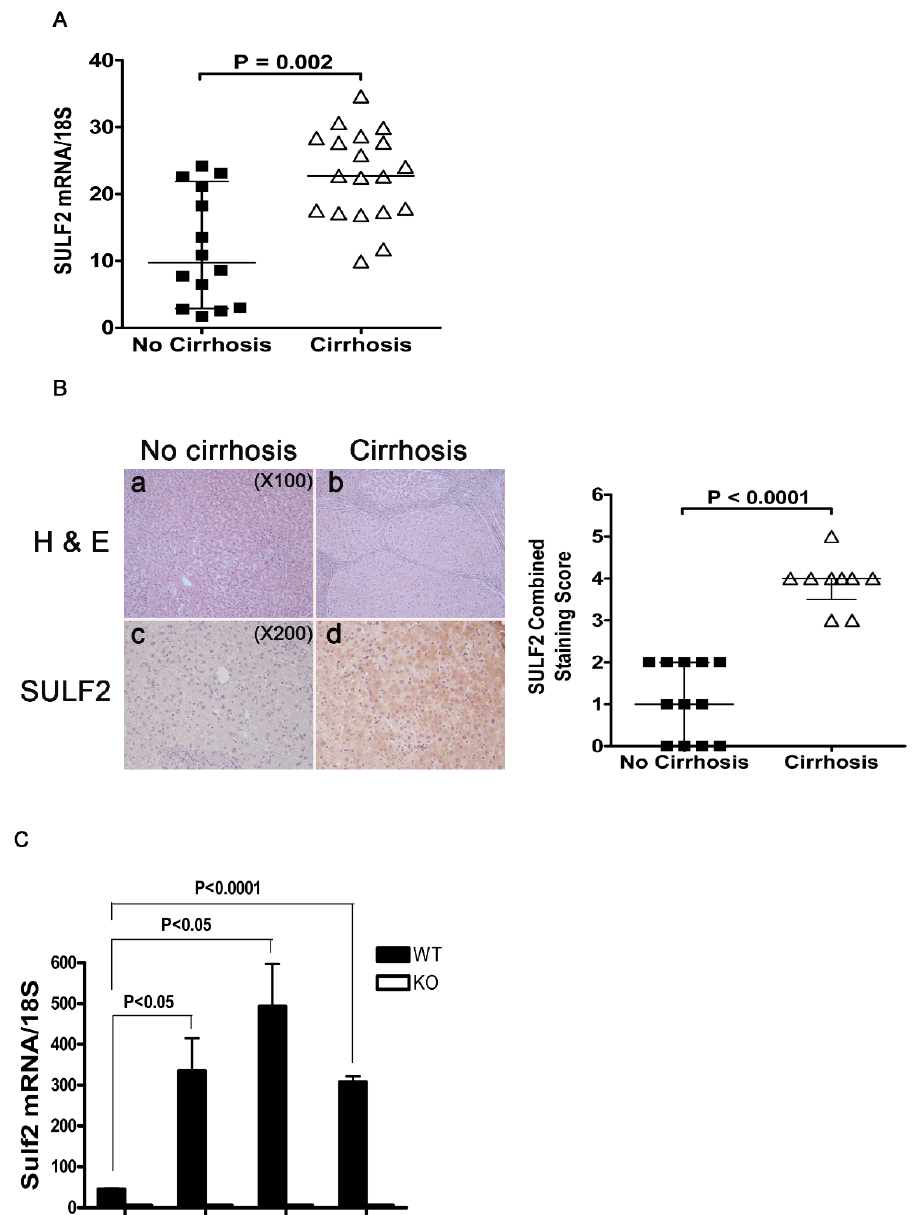
Figure 1. Expression of SULF2 in cirrhotic patients and mice with liver fibrosis. ( A ) The levels of SULF2 mRNA in liver samples and non-cirrhotic ( n = 14) patients. ( B ) Few inflammatory cells are observed in the portal tract without fibrotic changes (H&E, ×100) (a). The micronodular cirrhotic nodules are surrounded by thick fibrous tissue bands and numerous inflammatory cells (H&E, ×100) (b). The expression of SULF2 protein in the liver parenchyma adjacent to HCC is depicted in (c,d). All hepatocytes in non-cirrhotic liver parenchyma adjacent to HCC show no staining by sulf-2 antibody (c). Most hepatocytes in cirrhotic liver parenchyma adjacent to HCC are stained with sulf-2 antibody to varying degrees. The adjacent graph shows combined SULF2 staining scores in non-cirrhotic liver ( n = 12) and cirrhotic liver ( n = 10). ( C ) RT-PCR of SULF2 mRNA levels in mouse livers. Mice were sacrificed at 21 days after bile duct ligation (BDL), 8 weeks after treatment with carbon tetrachloride (CCL 4 ) and 6 weeks after treatment with thioacetamide (TAA). Data shown are representative of ten mice per genotype per time point and are presented as mean ± SEM.